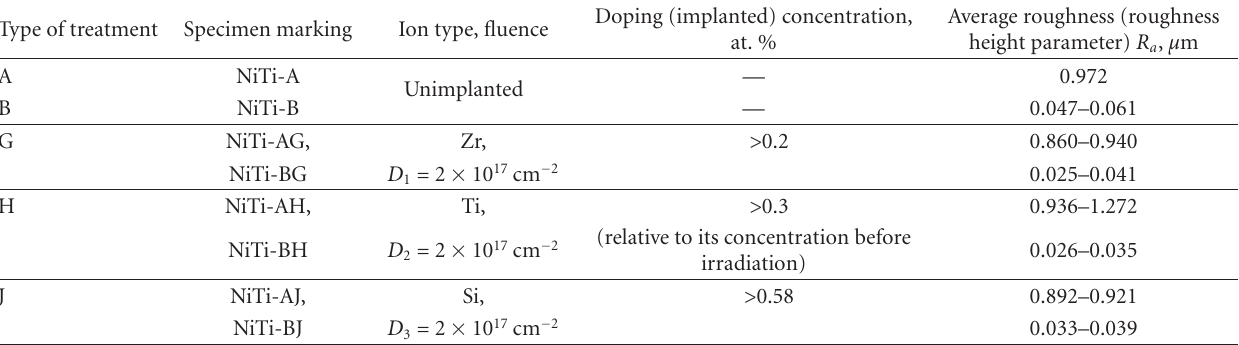
Table 2: Doping element concentration in the ion-implanted surface layers and average surface roughness (roughness height parameter) of the NiTi